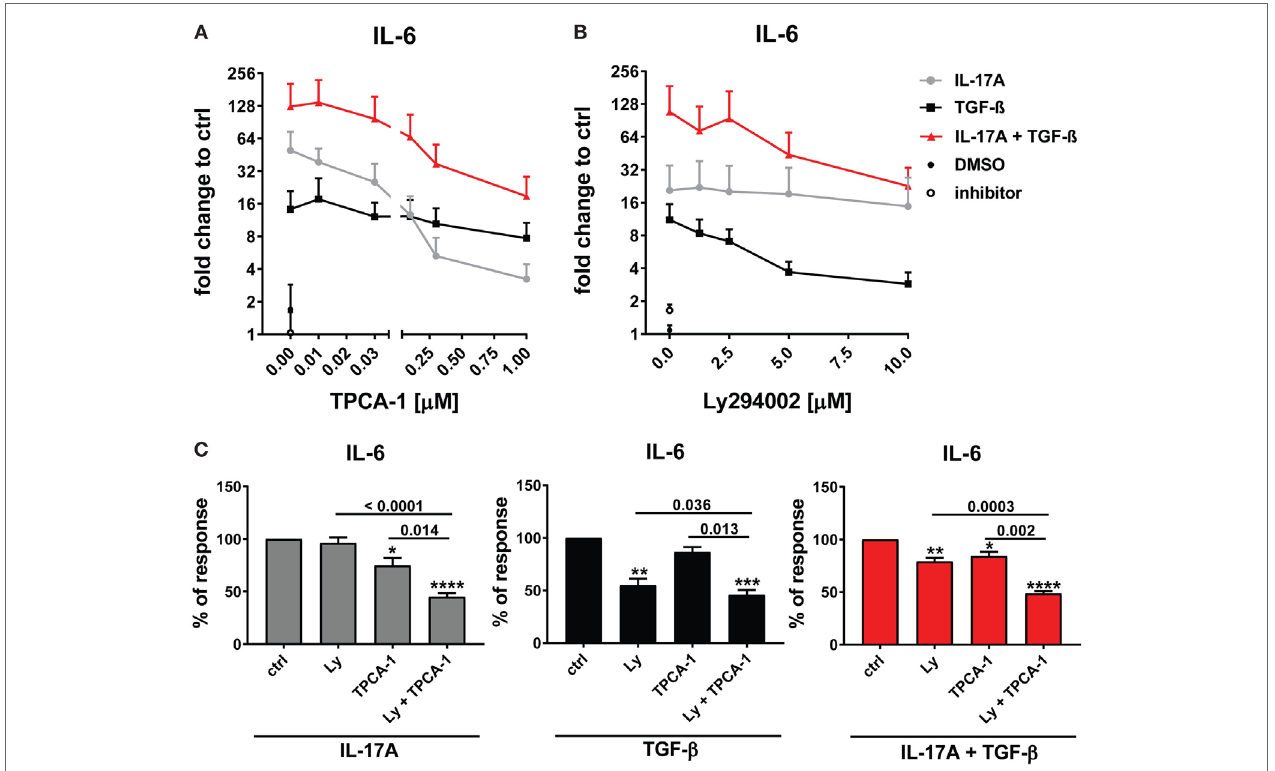
FigUre 4 | NF κ B and PI3K signaling pathways are preferentially used by IL-17A and TGF- β , respectively and together cooperate in inducing IL-6. Healthy donors fibroblasts were treated with the indicated concentrations of (a) TPCA-1; (B) Ly294002; or (c) suboptimal doses of TPCA-1 (0.03 µM) and/or Ly294002 (Ly, 2 µM) for 1 h prior to addition of IL-17A (25 ng/ml) and/or TGF- β (2.5 ng/ml). After 48 h, culture SNs were collected and IL-6 levels were assessed by ELISA. (a,B) Results are shown as fold change to untreated cells, mean + SEM is indicated ( N = 4). Please note the log 2 scale. (c) Results are shown as the percentage of IL-6 production induced by IL-17A and/or TGF- β in the absence of inhibitors (levels of IL-6 were: 86.2 ± 11.8 pg/ml for IL-17A, 49.6 ± 10.2 pg/ml for TGF- β , and 257.5 ± 82.5 pg/ml for IL- 17A + TGF- β ). Bars represent the mean + SEM. Significant differences versus control were assessed by paired t -test: * P < 0.05, ** P < 0.01, *** P < 0.001, **** P < 0.001.